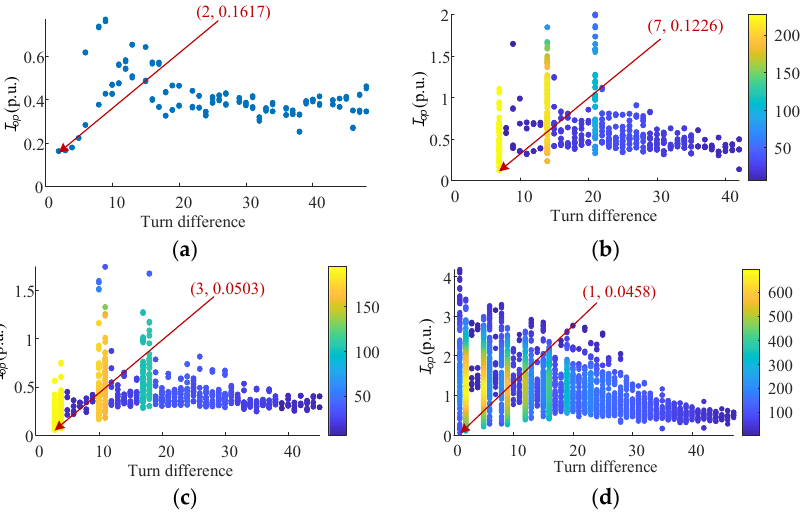
Figure 10. When s = − 0.1, the simulation results of all possible internal short ‐ circuit faults in rotor windings: ( a ) in ‐ slot faults; ( b ) end faults in the same branch with different short turns; ( c ) end faults between two branches in the same phase; ( d ) end faults between phases.